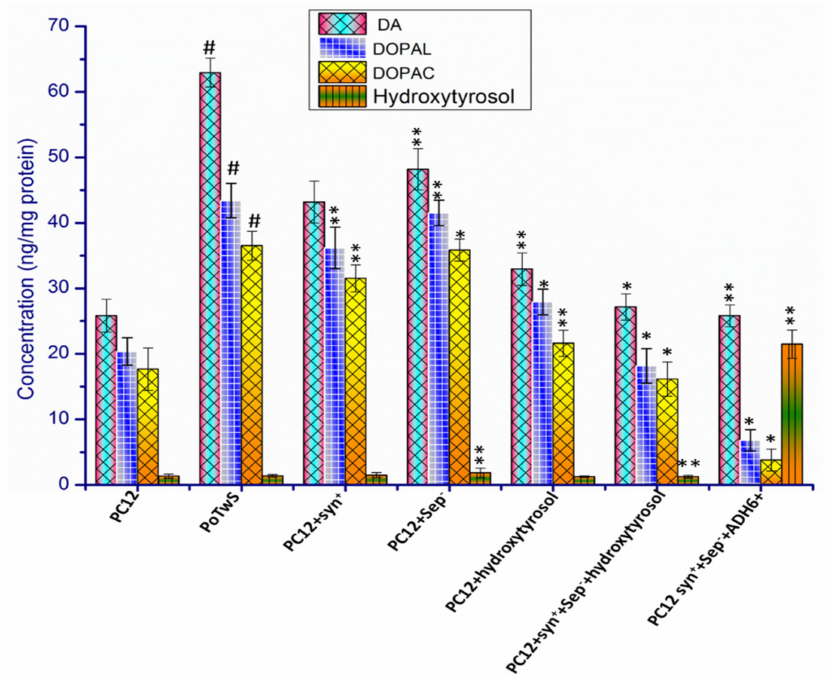
Figure 6. HPLC analysis of dopamine (DA) and its metabolites. The cytoplasmic accumulation of DA, DOPAL, and DOPAC was determined in PC12, PoTwS, PC12 + syn + , PC12 + sep − , PC12 + hydroxytyrosol, PC12 + syn + + sep − + hydroxytyrosol, and PC12 + syn + + sep − + ADH + cells. PC12 + syn + + sep − + ADH + cells displayed the lowest level of DA, DOPAL, and DOPAC production compared to the other cell lines. The description of each cell line is given in Supplementary Table S3. Data are mean and S.E. values from three independent experiments ( n = 3). # p < 0.05, relative to control cells (PC12 cells). * p < 0.05 and ** p < 0.01, relative to the cells treated only with